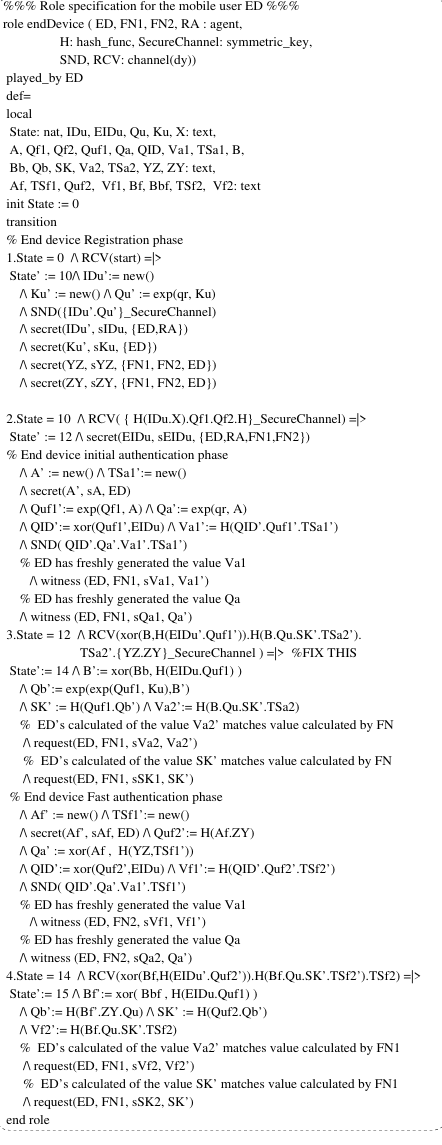
Figure 6. HLPSL role specification for an end